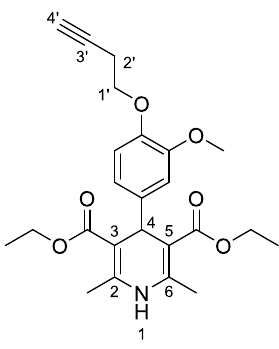
Figure 15. Chemical stucture of 3n .